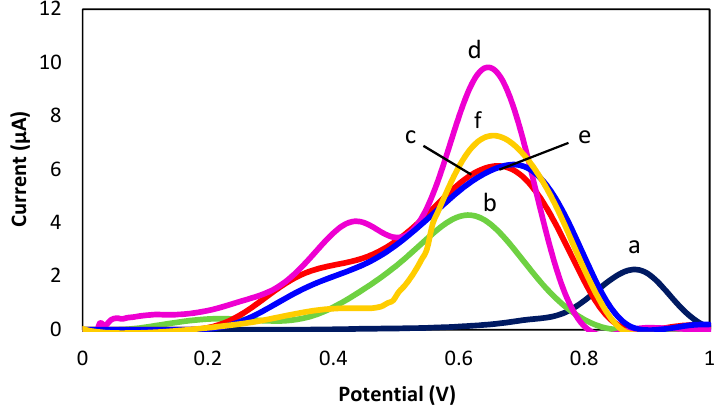
Figure 5. DPV responses of (a) bare SGPE; (b) SPGE/GP/PANI; (c) SPGE/GP/PANI/CapAb; (d) SPGE/GP/PANI/CapAb/CFP10/Ab-Fe@Au; (e) SPGE/GP/PANI/CapAb/BSA/Ab-Fe@Au and (f) SPGE/Fe@Au in 0.01 M PBS solution (pH 7.4).